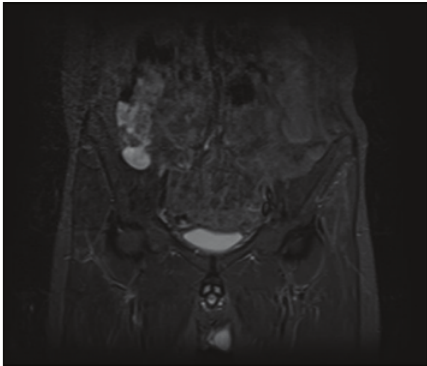
Figure2:MRIofaccumulatedsuppurativefluidwithintheiliopsoas